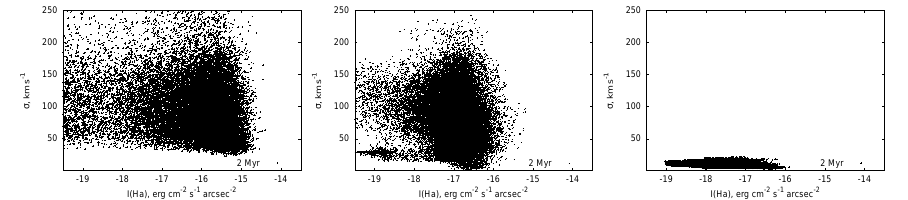
Fig. 5. The I H (cid:11) { (cid:27) diagrams for continuous SN explosions with a rate of 1 : 25 (cid:2) 10 (cid:0) 11 pc (cid:0) 3 Myr (cid:0) 1 (1 SN per 10 4 yrs in a 200 pc 3 box, the left panel), 1 : 25 (cid:2) 10 (cid:0) 12 pc (cid:0) 3 Myr (cid:0) 1 (1 SN per 10 5 yrs in a 200 pc 3 box, the middle panel) and for a limited (15) number of SNe exploding with a delay of 10 4 yrs (the right panel) at t = 2 Myr. case of limited SN number, the SN shells lose their energy during (cid:24) 1 Myr (in gas with n = 0 : 1 cm − 3 ) after the last SN has exploded, thus, both H (cid:11) intensity and velocity dispersion drop to negligible values (Fig. 5, right